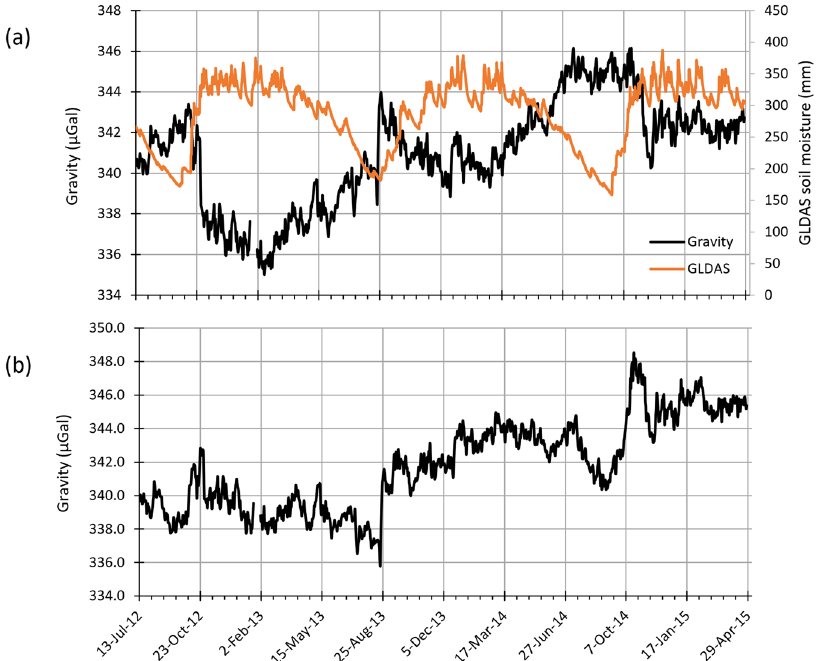
Fig. 8 Gravity correction of hydrological effects. a Residual iGrav gravity signal before hydrological correction (Black curve) and top 1 m soil moisture content from GLDAS models (Orange curve); ( b ) Hydrology corrected residual